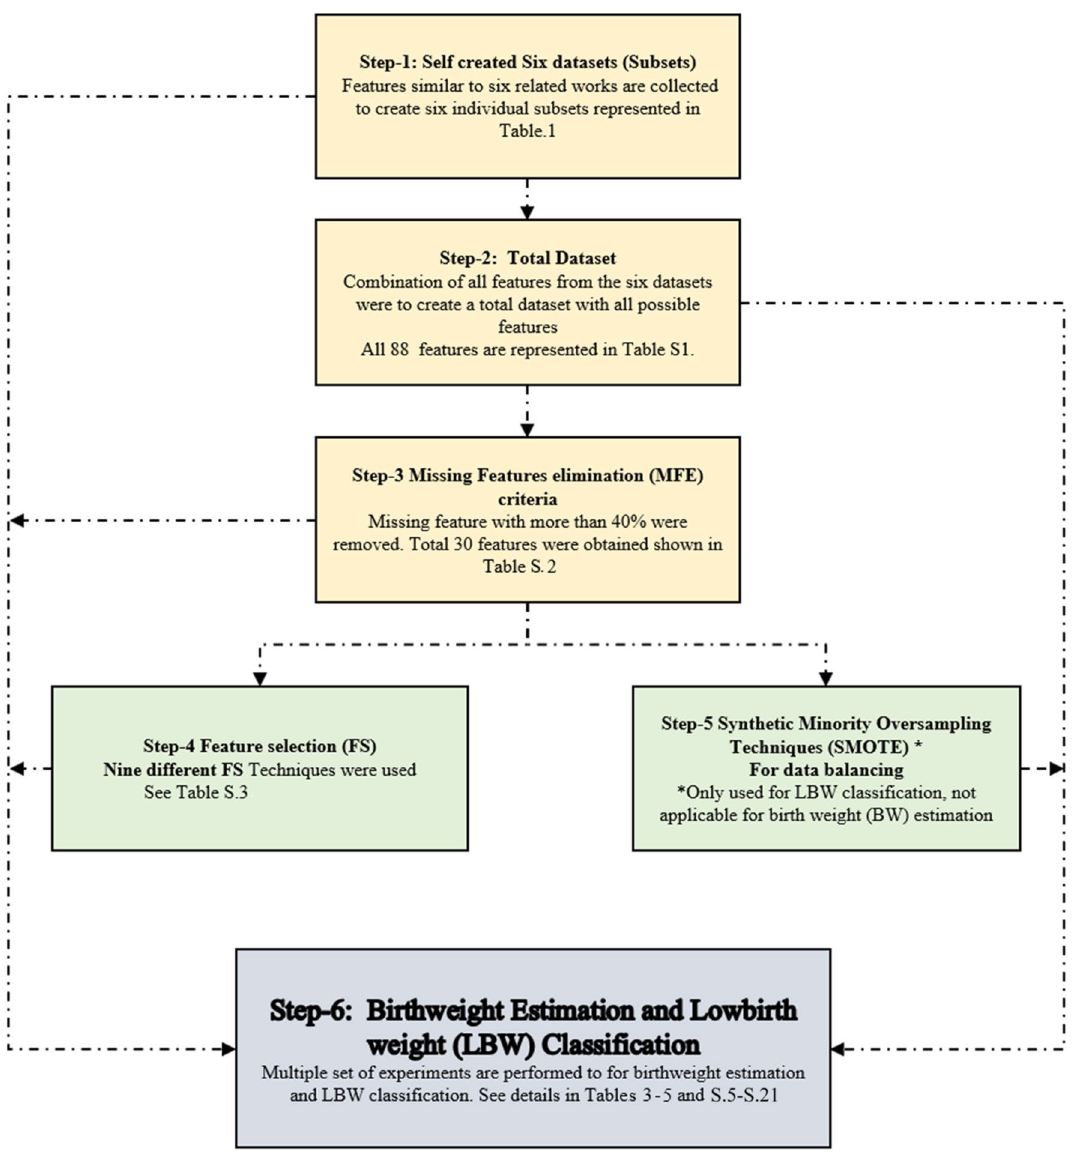
Figure 1. Proposed ML framework for infant weight estimation and LBW